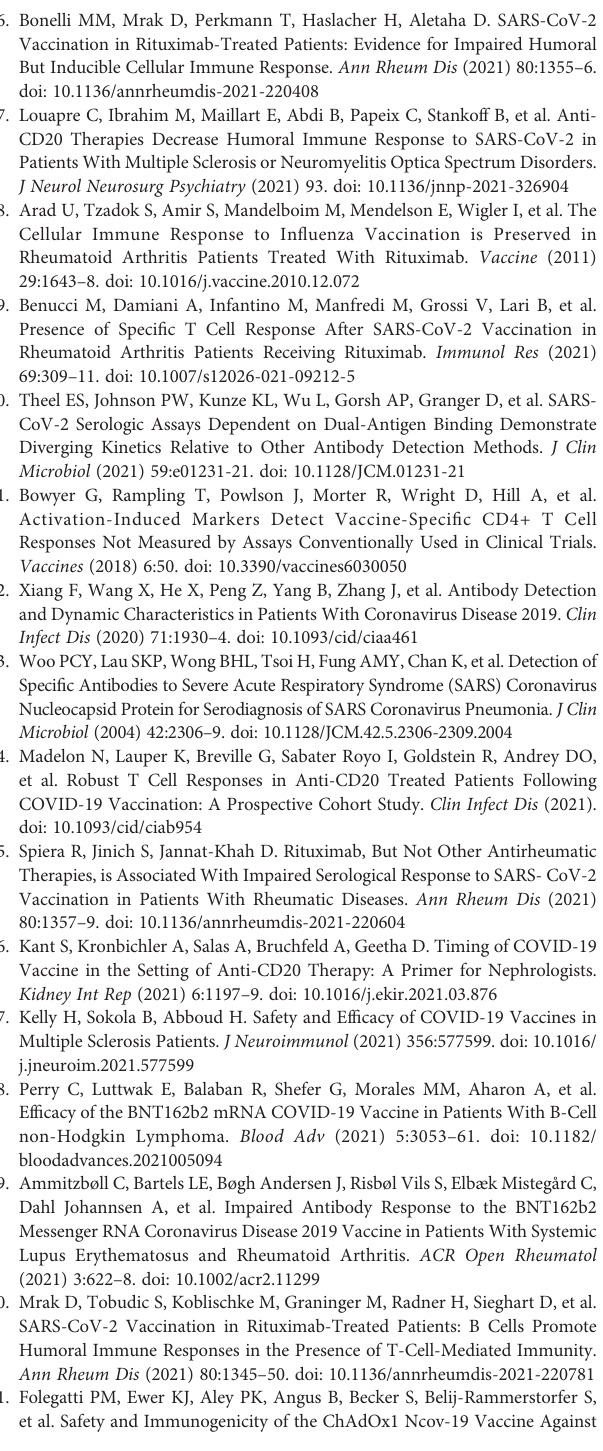
Supplementary Figure 5 | Anti-SARS-CoV-2 Spike T-cell responses measured by IFN g ELISPOT positive spots using different antigens in B-cell depleted patients and normal subjects broken down by vaccine type. (A). S1 subunit SARS-COV-2 spike glycoprotein (B) . S2 subunit SARS-COV-2 SPIKE, (C). SARS-COV-2 SPIKE peptide pool (JPT v1-158P), (D). SARS-COV-2 spike peptide pool (JPT v2-157P), (E). SARS-COV-2 spike RBD peptide pool and (F) Tetanus